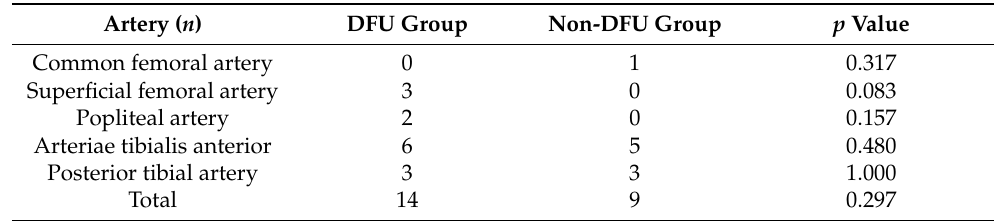
Table 3. Ultrasound findings of the lower limb artery severe stenosis or occlusion in 16 patients with unilateral diabetic foot